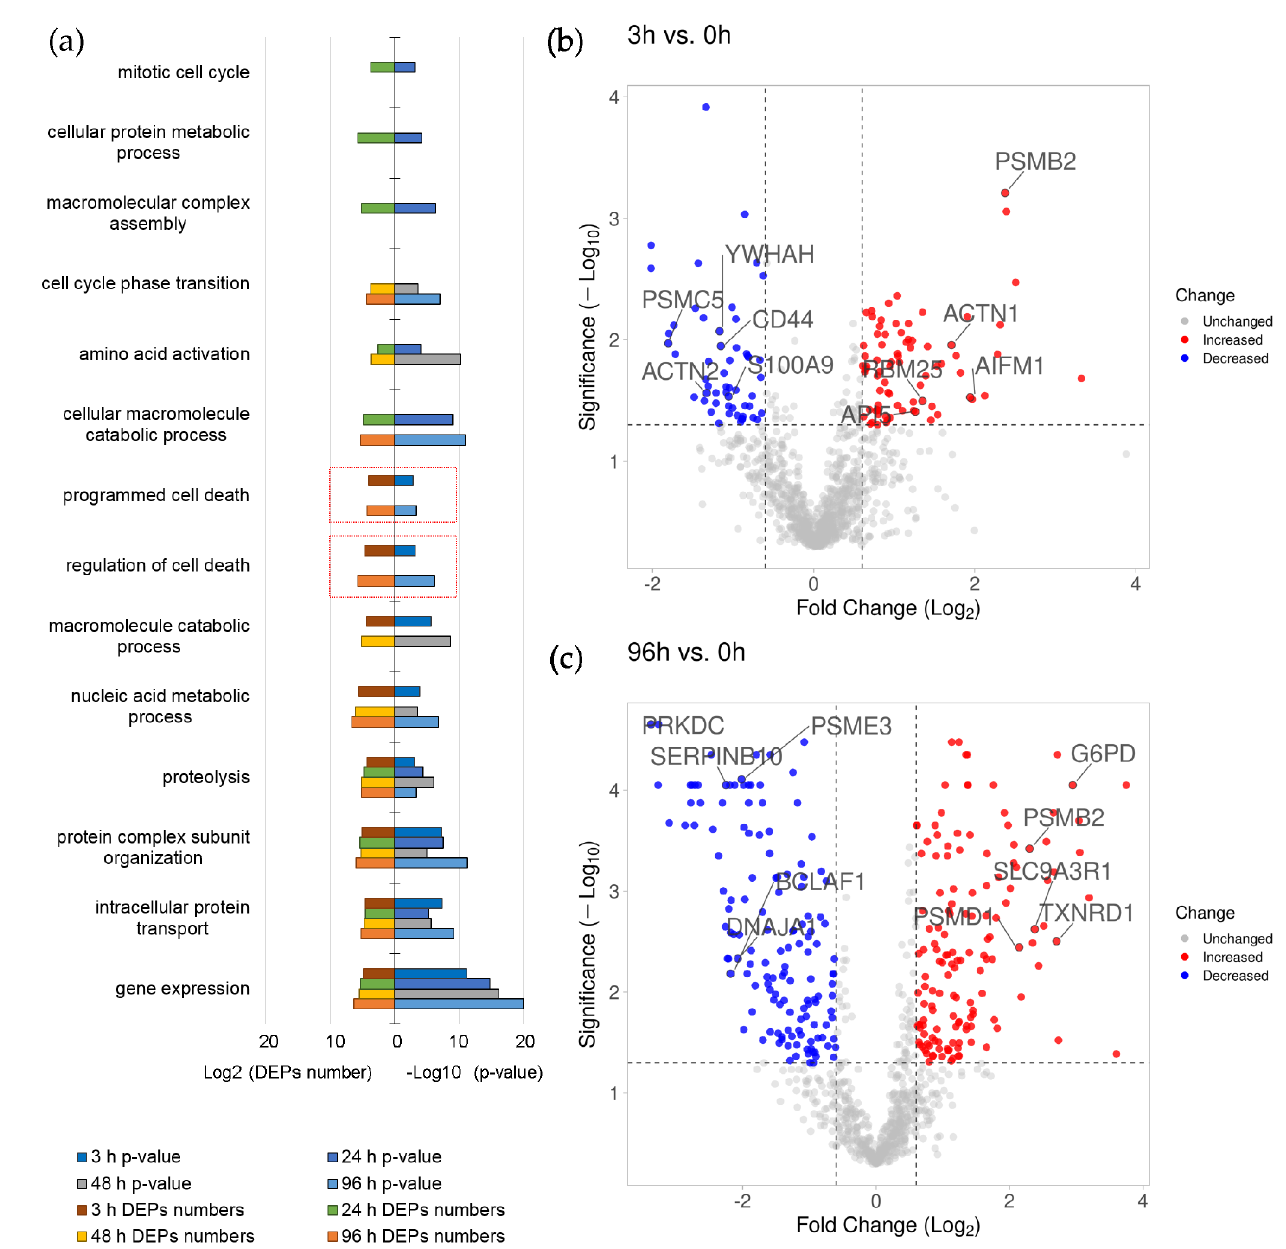
Figure 3. ( a ) The functional GO analysis of differentially expressed proteins (DEPs) of HL-60 cells at 3 h, 24 h, 48 h, and 96 h after ATRA treatment. The number of DEPs (Log2 transformed) and p -value (-Log10 transformed) are provided on the x-axis. The groups from the category of “Biological process” are on the y-axis. The threshold adjusted p -value < 10 − 4 . The groups containing proteins regulating cell death and apoptosis are marked by red. The volcano plots show the differences in proteins abundance at 3 h ( b ) and 96 ( c ) after ATRA treatment; significantly up- and down-regulated proteins are shown as red and blue dots, respectively; names are shown for five most up- and down-regulated proteins that were annotated by GO belonging to groups “programmed cell death” and/or “regulation of cell death”.